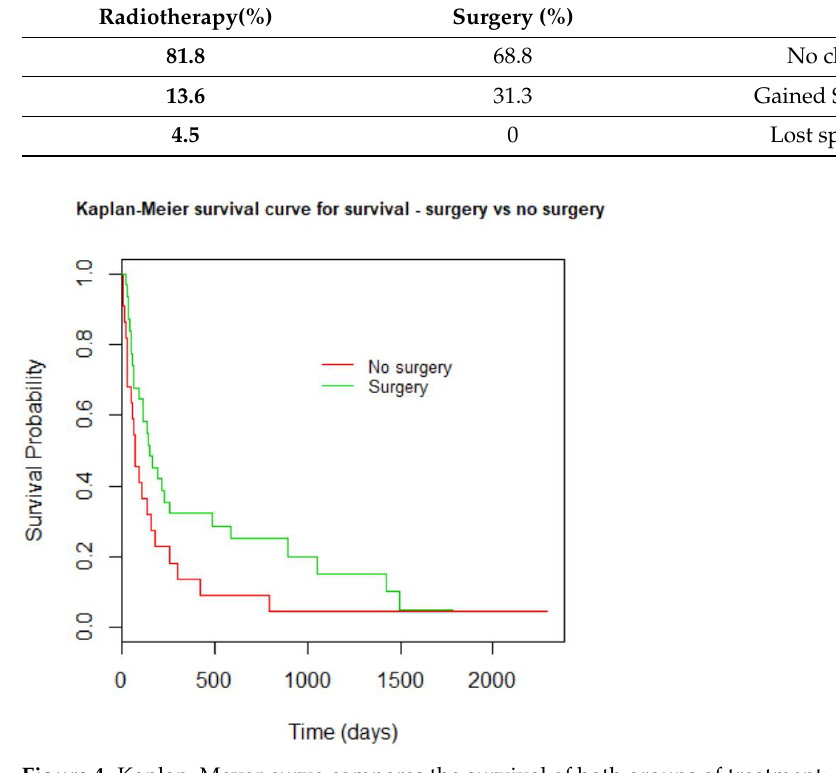
Figure 4. Kaplan–Meyer curve compares the survival of both groups of treatment: surgical interven- Figure 4. Kaplan – Meyer curve compares the survival of both groups of treatment: surgical inter- vention vs. radiation therapy alone. p = 0.0765. tion vs. radiation therapy alone. p =